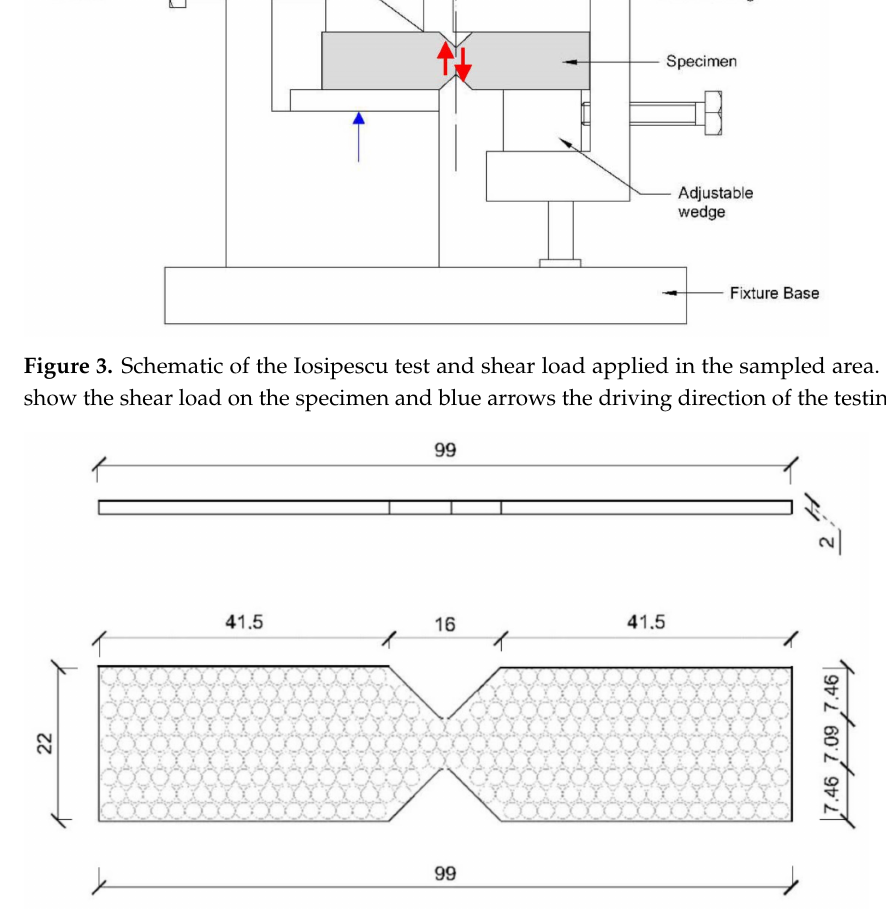
Figure 4. Drawing of the shear specimens extracted from the